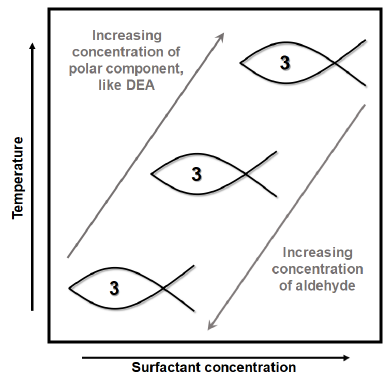
Figure 4. Schematical phase diagram of a ternary mixture of oil, water, and a non-ionic surfactant with illustrated shifts of the three-phase area (3) depending on added components, α = 0.5, adapted from